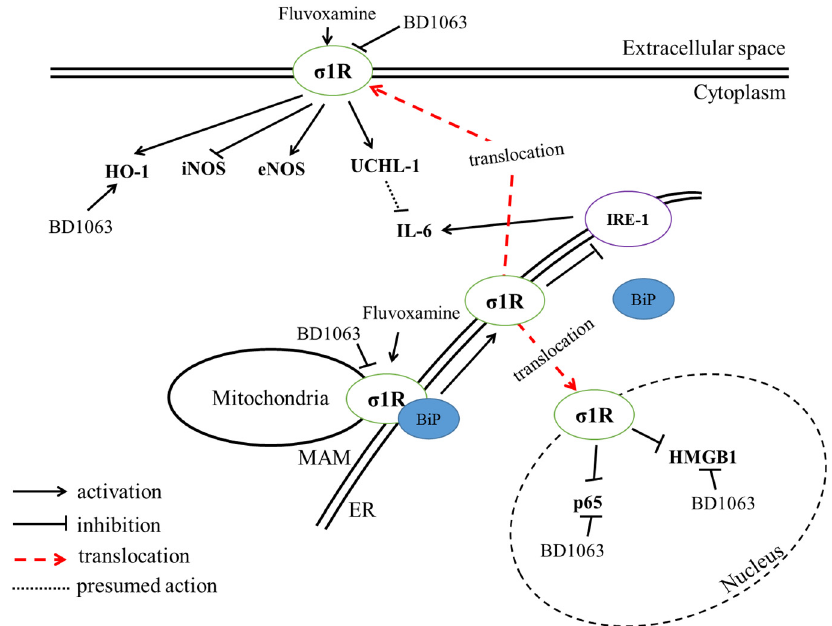
Figure 11. Summary of the suggested action of Sigma-1 receptor ( σ 1R) agonist, fluvoxamine, and antagonist, BD1063. Heme oxygenase-1 (HO-1); inducible nitric oxide synthase (iNOS); endothelial NOS (eNOS); ubiquitin C-terminal hydrolase ligase (UCHL-1); interleukin-6 (IL-6); endoplasmic reticulum (ER); mitochondria-associated ER-membrane (MAM); binding immunoglobulin protein (BiP); inositol-requiring enzyme 1 α (IRE-1), p65 (NF- κ B subunit); high mobility group box-1 (HMGB- 1).